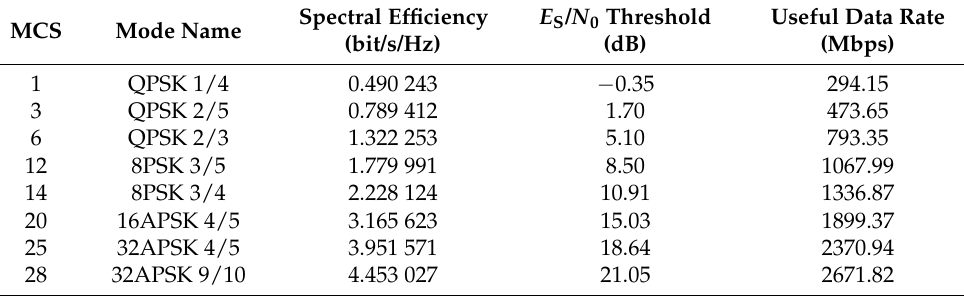
Table 1. Characteristic of MCSs recommended by